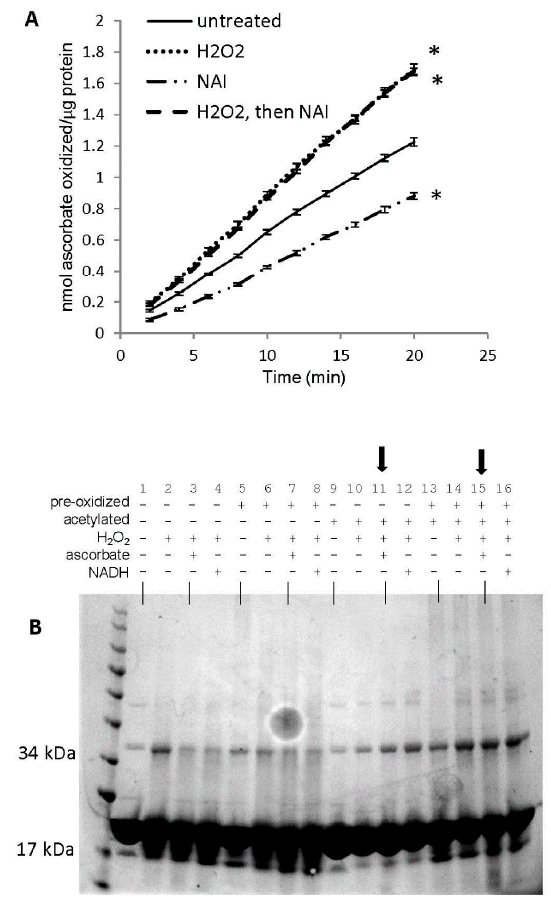
Figure 10. Role of tyrosine residues in regulating oxidatively-modified metMb species. ( A ) Peroxidase activity assay of metMb that had been treated with H 2 O 2 alone, N-acetylimidazole (NAI) alone or H 2 O 2 and then NAI (as described in methods and materials) using 200 µM H 2 O 2 and 250 µM ascorbic acid at pH 6.1. * p ≤ 0.05 compared to untreated control, n = 6/group. Activity plots for H 2 O 2 and NAI groups overlap, so they are not both visible. ( B ) Coomassie stains of the samples prepared in ( A ). Lanes 1–4: untreated, control metMb; H 2 O 2 -treated, control metMb; H 2 O 2 -treated control metMb + ascorbic acid; H 2 O 2 -treated control metMb + NADH. Lanes 5–8: same as (1–4) only using met Mb that had been reacted with H 2 O 2 (pre-oxidized). Lanes 9–12: same as (1–4) and (5–8) only using NAI-